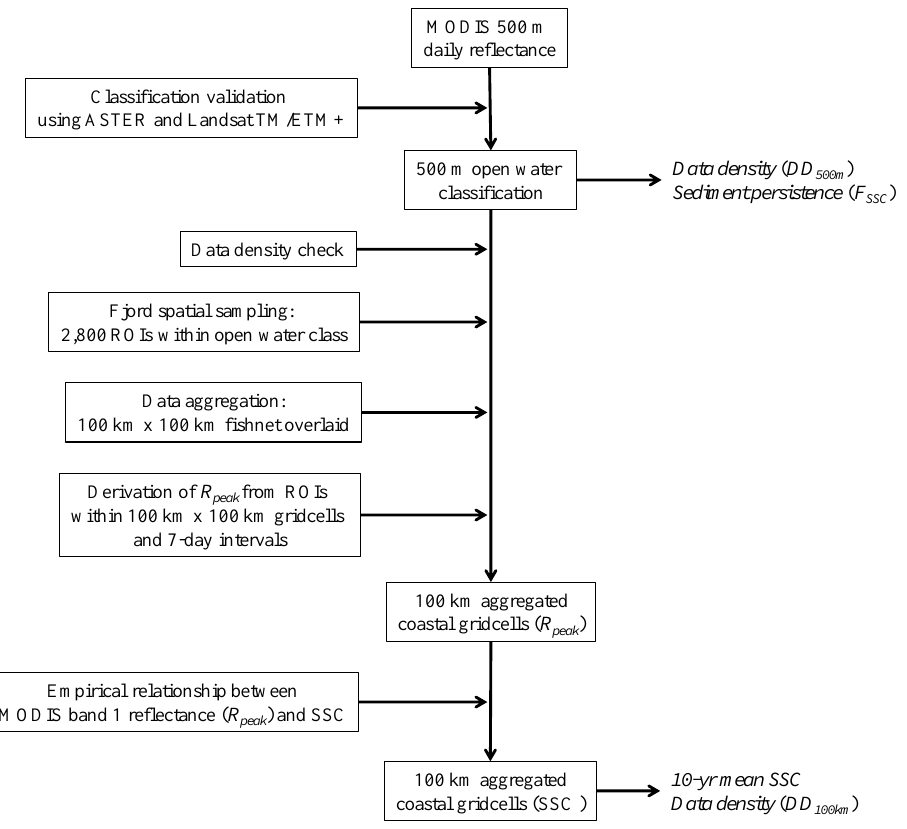
Fig. 1. Methodology flowchart of MODIS remote sensing of sediment plumes. Daily 500m MODIS reflectance data were classified to identify open water pixels ranging from clear water to sediment-rich water, spatially validated using higher-resolution ASTER and Landsat TM/ETM+. Resulting 500m open water classification produced measures of sediment persistence and data density. To increase temporal sampling, data were aggregated into 100km coastal gridcells, whose value was represented by R peak within the gridcell and a 7-day interval. R peak was derived from fjord ROIs that met a data density threshold. SSC was extracted for each 100km coastal gridcell using an empirical model relating MODIS band 1 reflectance ( R peak ) and SSC (Fig. 4). New measures of sediment persistence and data density along with average SSC were calculated from these